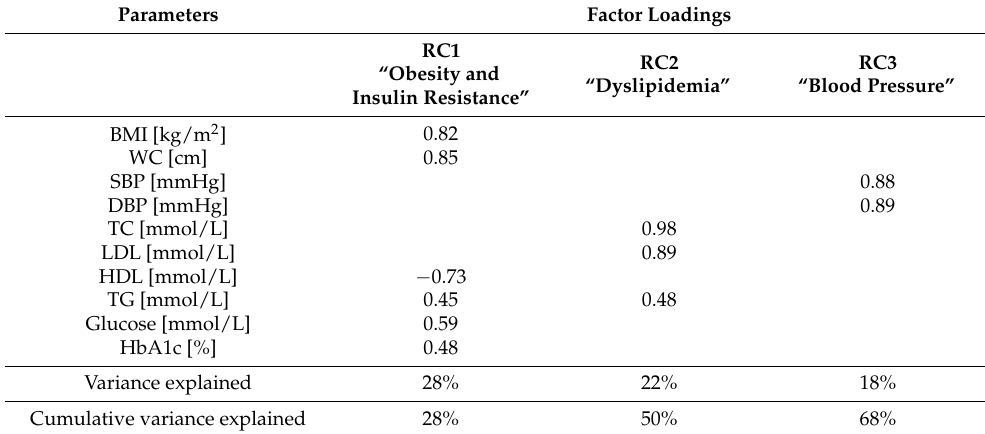
Table 4. Variable loadings and percent of variance explained by each principal component.